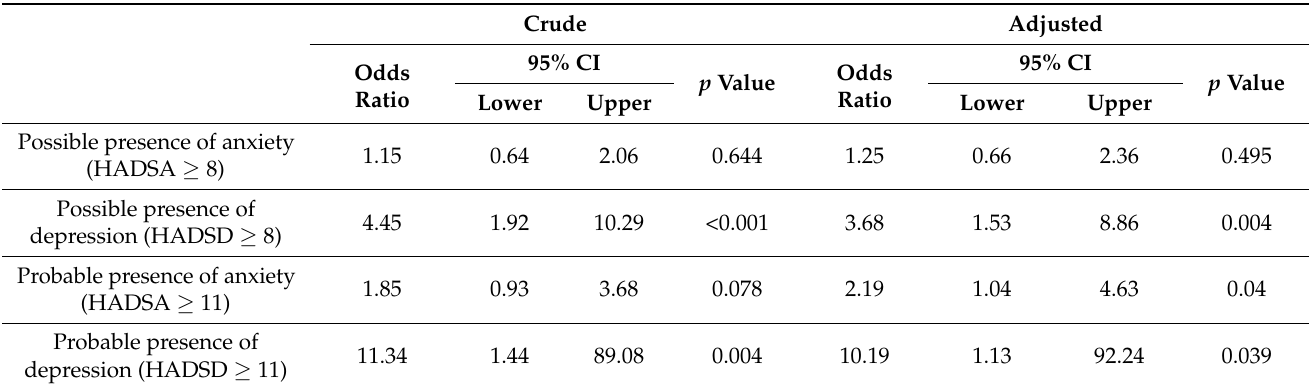
Table 2. Risk of anxious or depression symptomatology according to malnutrition. Adjusted for age, sex, and cancer stage.